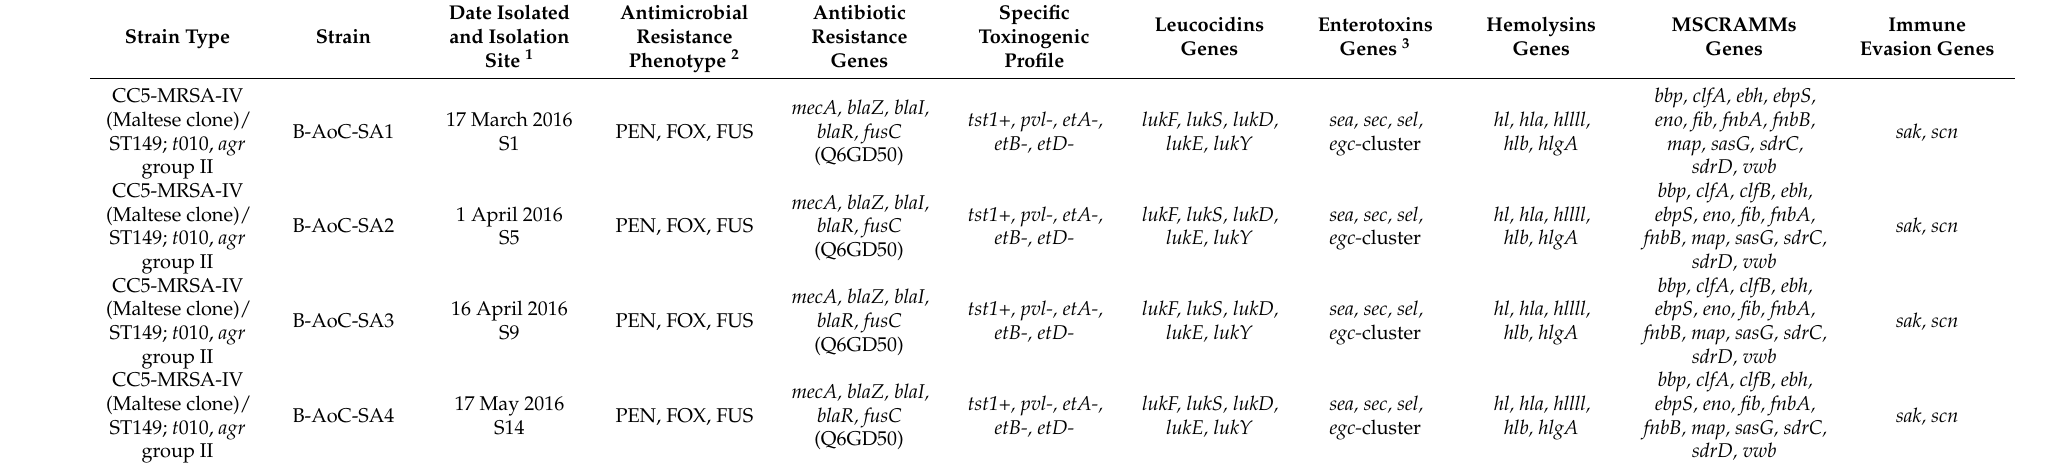
Table 2. Characteristics of MRSA isolated from bat guano in Aokas’s cave (Bejaia,